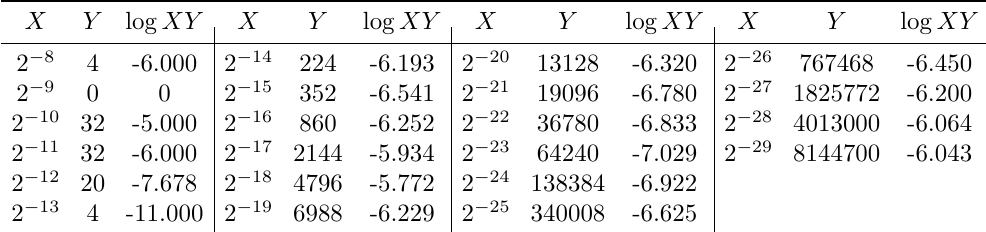
Table 5: Evaluation of Differential Probability with MILP. MILP found Y distinct characteristics with probability X , and its contribution is calculated by XY